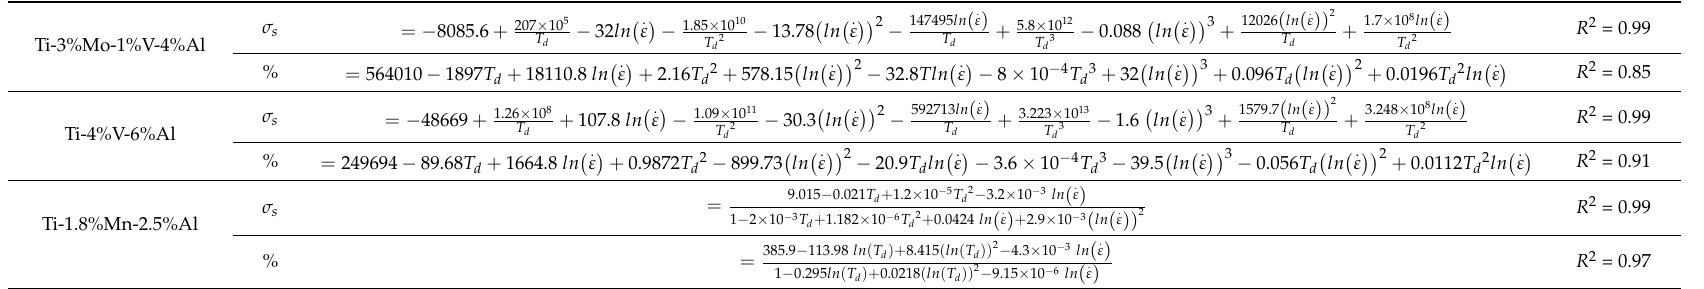
Table 2. Empirical expressions of the σ s and elongation to failure. ( T d is the deformation temperature ( ◦ C), and